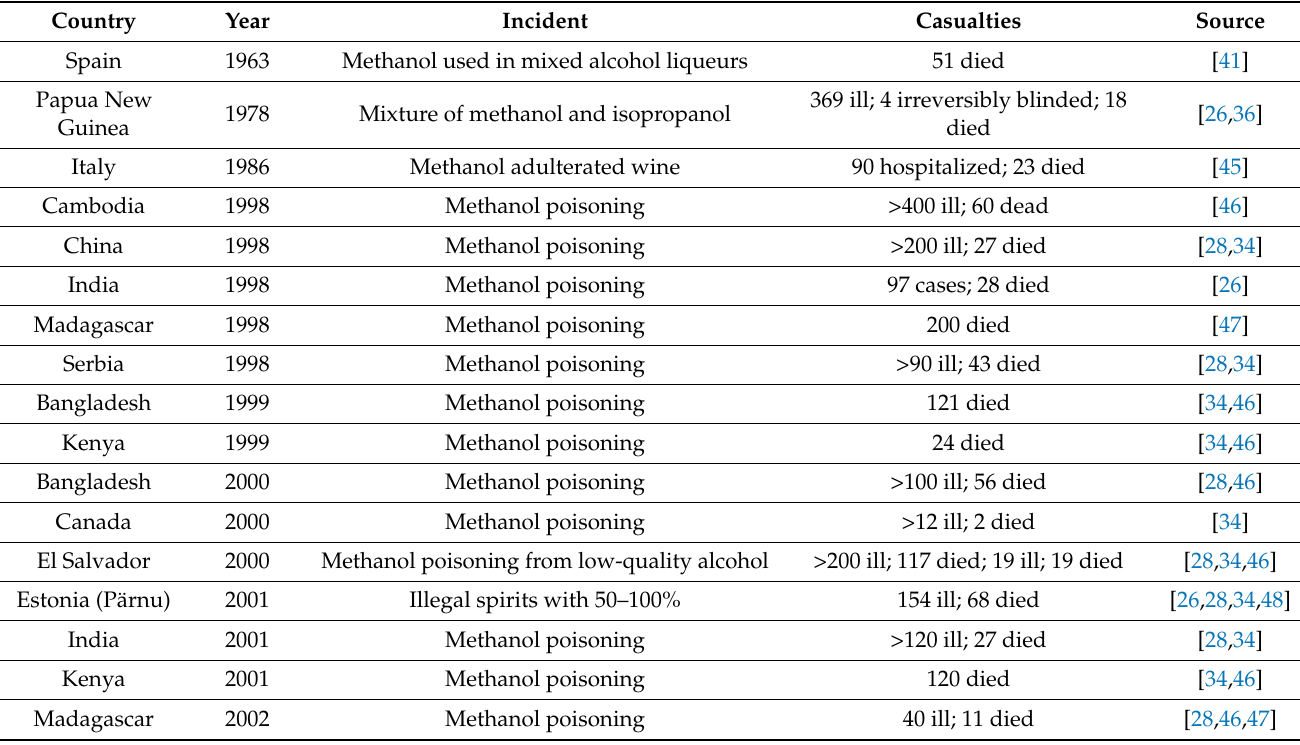
Table 1. Examples of toxic methanol incidents (1963–2020) highlighted in the academic literature and the media search ( n =